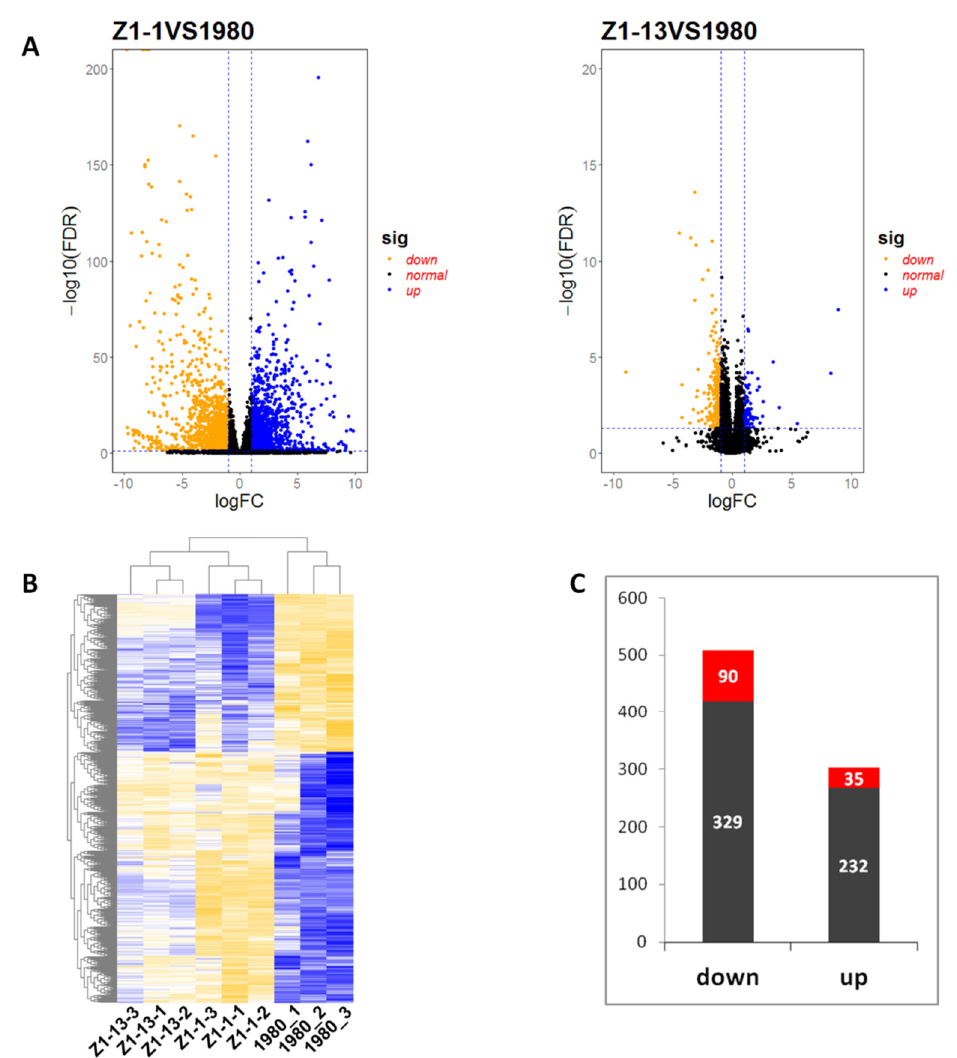
Figure 5. Differentially expressed genes (DEGs) between wild-type stain 1980 and Open Reading Frame I ( ORF I )-expressing mutant strains Z1-1 or Z1-13. ( A ) Volcano plot displaying –log10 (FDR) on the Y-axis, index of gene differences p -value from NOIseq, and Log2 (fold-change) on the X-axis. The blue dots represent up-regulated DEGs between transformants and wild-type strain 1980, yellow dots represent down regulated DEGs, and black dots indicate genes without statistical significance. ( B ) Heat map of all DEGs. Row clustering was carried out based on relative expression level of genes. The column represents the individual treatment sample. Down-regulated DEGs are displayed in yellow, and up-regulated DEGs are displayed in blue. The brightness of each color corresponds to the magnitude of the difference when compared against the average value. ( C ) The number of common DEGs in mutant strains Z1-1 and Z1-13. Red columns represent DEGs with significant difference. Of these significantly DEGs, four genes (sscle_05g047430, sscle_11g081370, sscle_11g081390 and sscle_11g081490) inhibited in wild-type strain 1980 were induced in mutant strains Z1-1 and Z1-13. Among them, gene sscle_05g047430 (SS1G_05768) was a cysteinyl-tRNA synthetase participating in